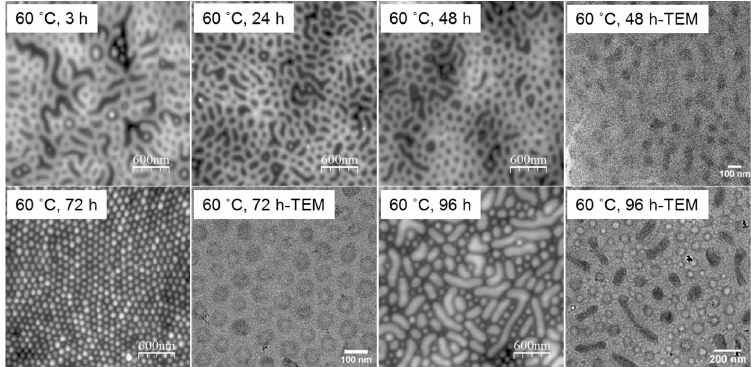
Figure 6. AFM height profiles and TEM images of the 80-nm PS- b -P2VP thin films spin-coated at 2500 rpm from 1.5 wt % solution in toluene with further annealing in toluene vapor atmosphere at 60 °C.